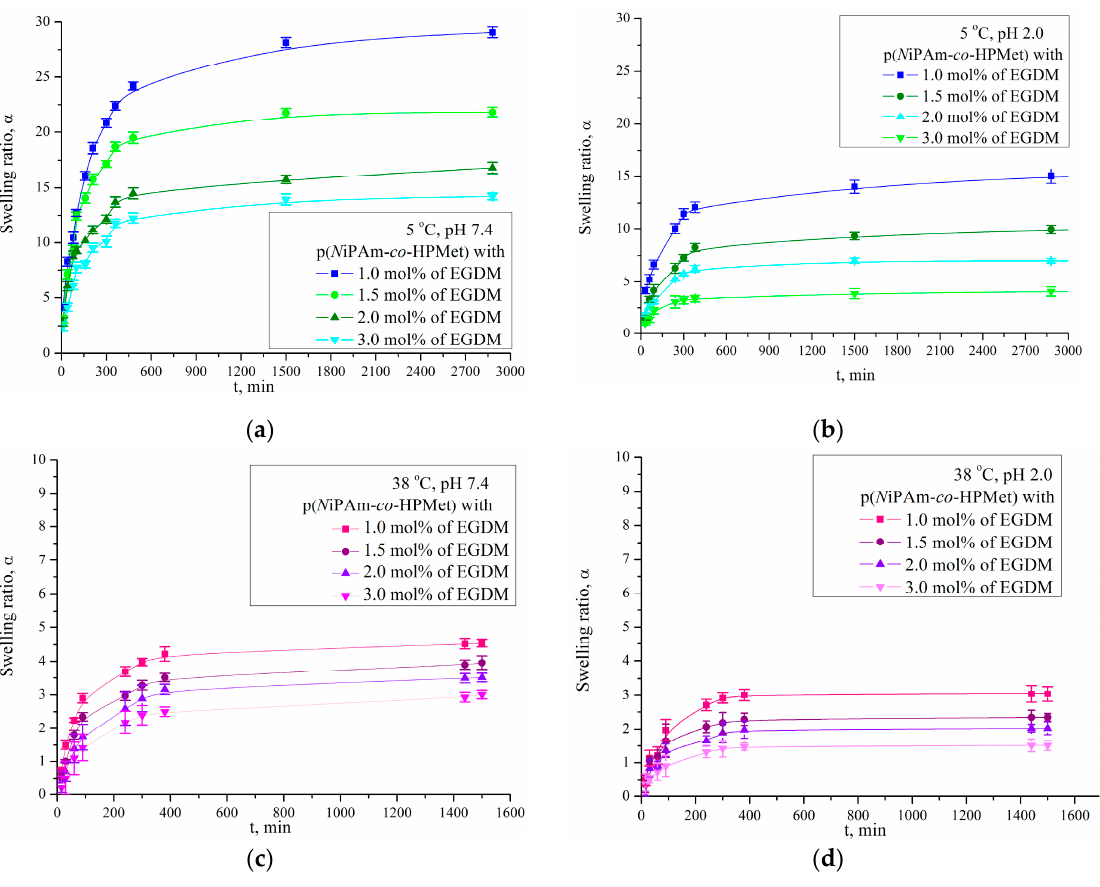
Figure 1. Change in the swelling ratio, α , of p( N iPAm- co -HPMet) with 15 mol% HPMet and 1.0; 1.5; 2.0 and 3.0 mol% of EGDM, depending on temperature at: ( a ) 5 °C and pH 7.4; ( b ) 5 °C and pH 2.0, ( c ) 38 °C and pH 2.0; ( d ) 38 °C and pH 2.0. In each figure, error bars represent the standard deviation of three replicates.